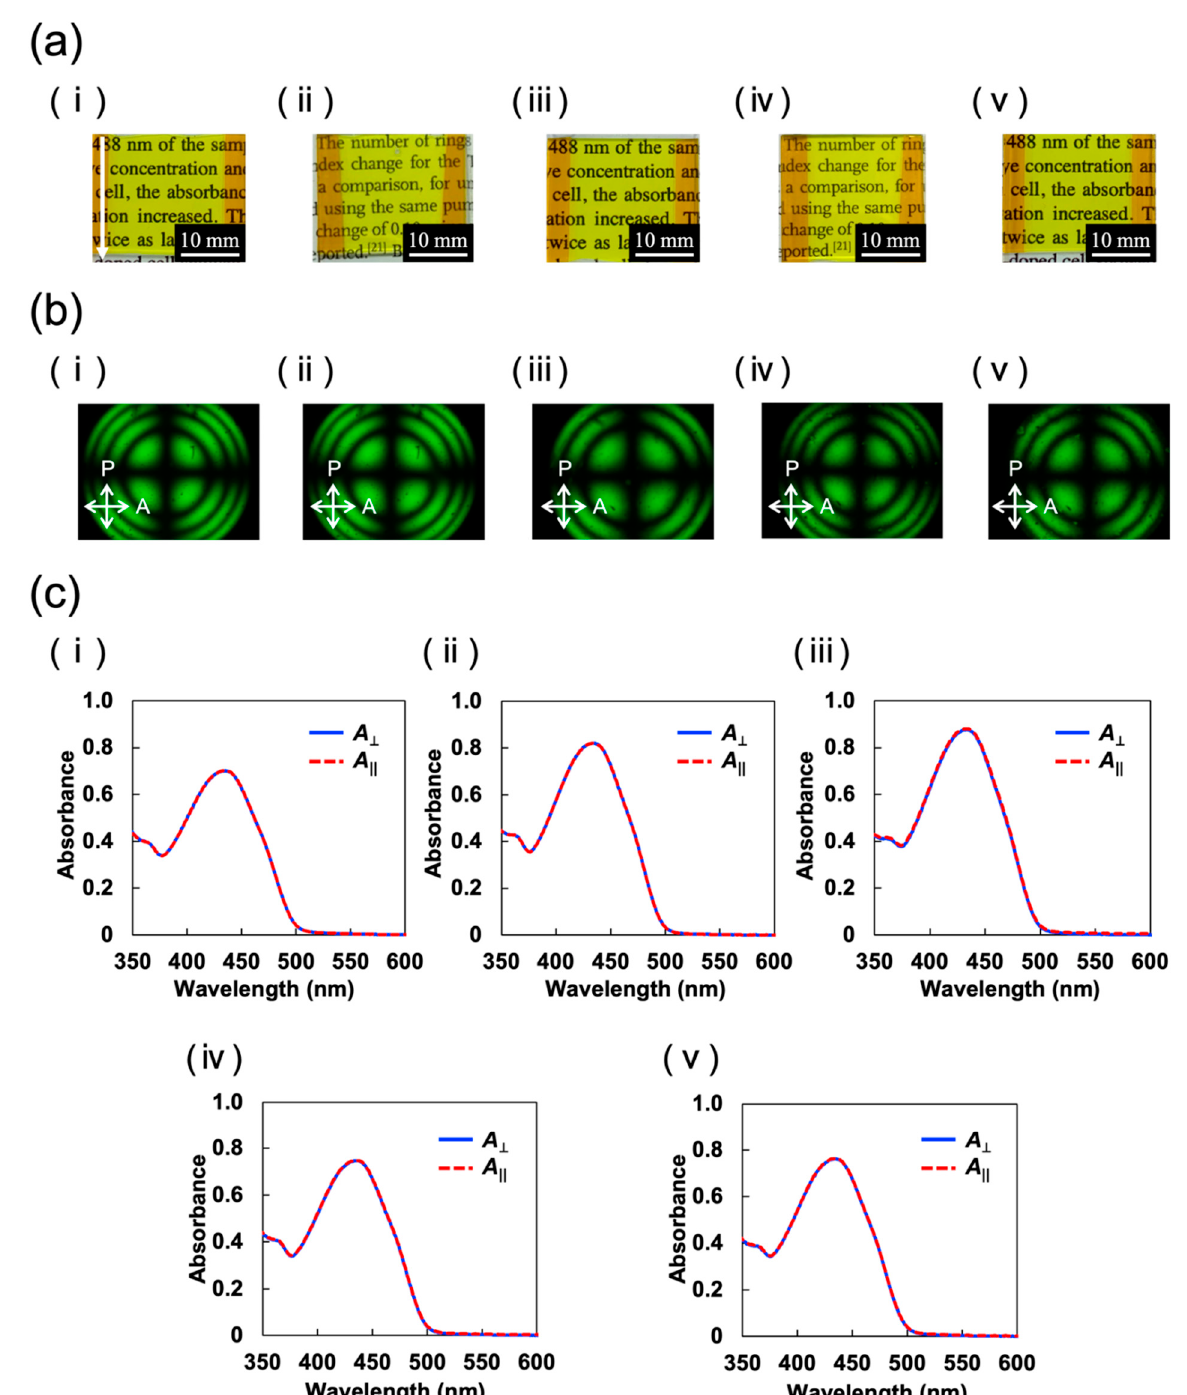
Figure 5. ( a ) Photographs, ( b ) conoscopic POM images, and ( c ) polarized UV-vis absorption spectra of prepared samples: ( i ) TR5/5CB, ( ii ) TR5/(5CB F-LC1), ( iii ) TR5/(5CB F-LC2), ( iv ) TR5/(5CB F-LC3), and ( v ) TR5/(5CB F-LC4). Blue solid and red dash lines in ( c ) denote the absorption perpendicular ( A ⊥ ) and parallel ( A ∥ ) to the direction of sample injection, respectively.